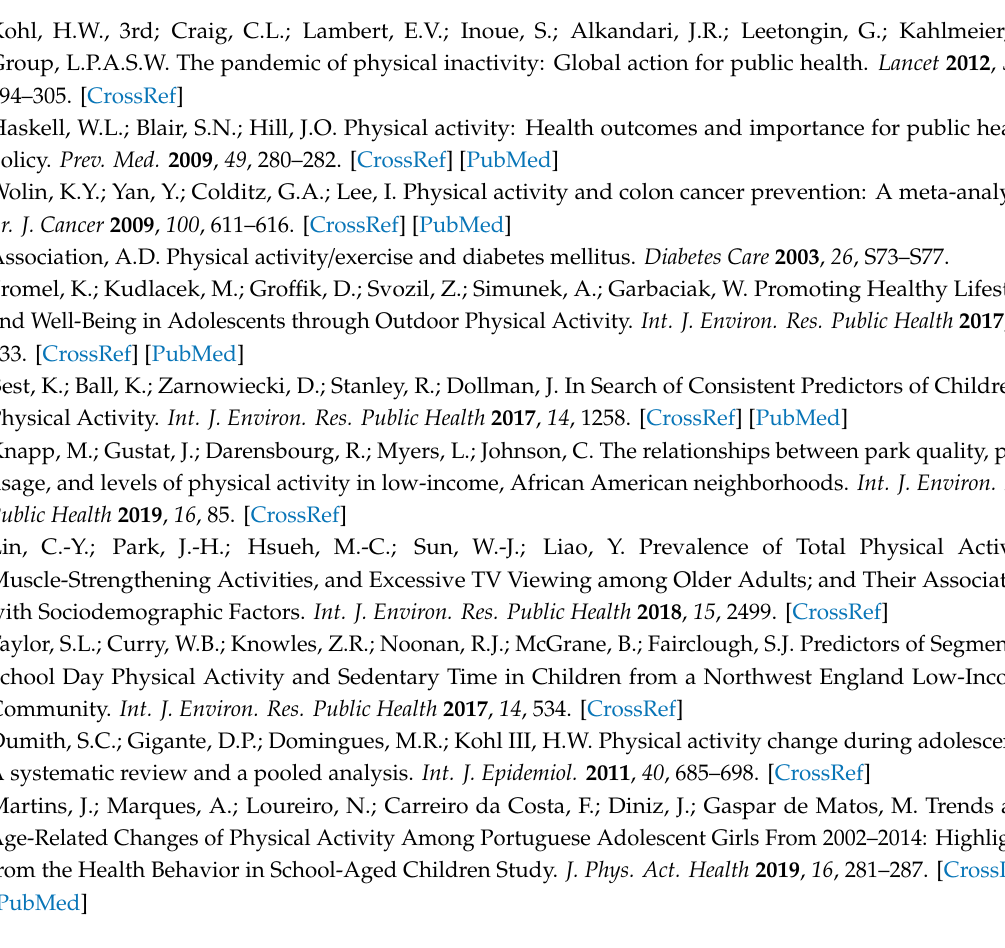
Table S1: Frequencies for studied